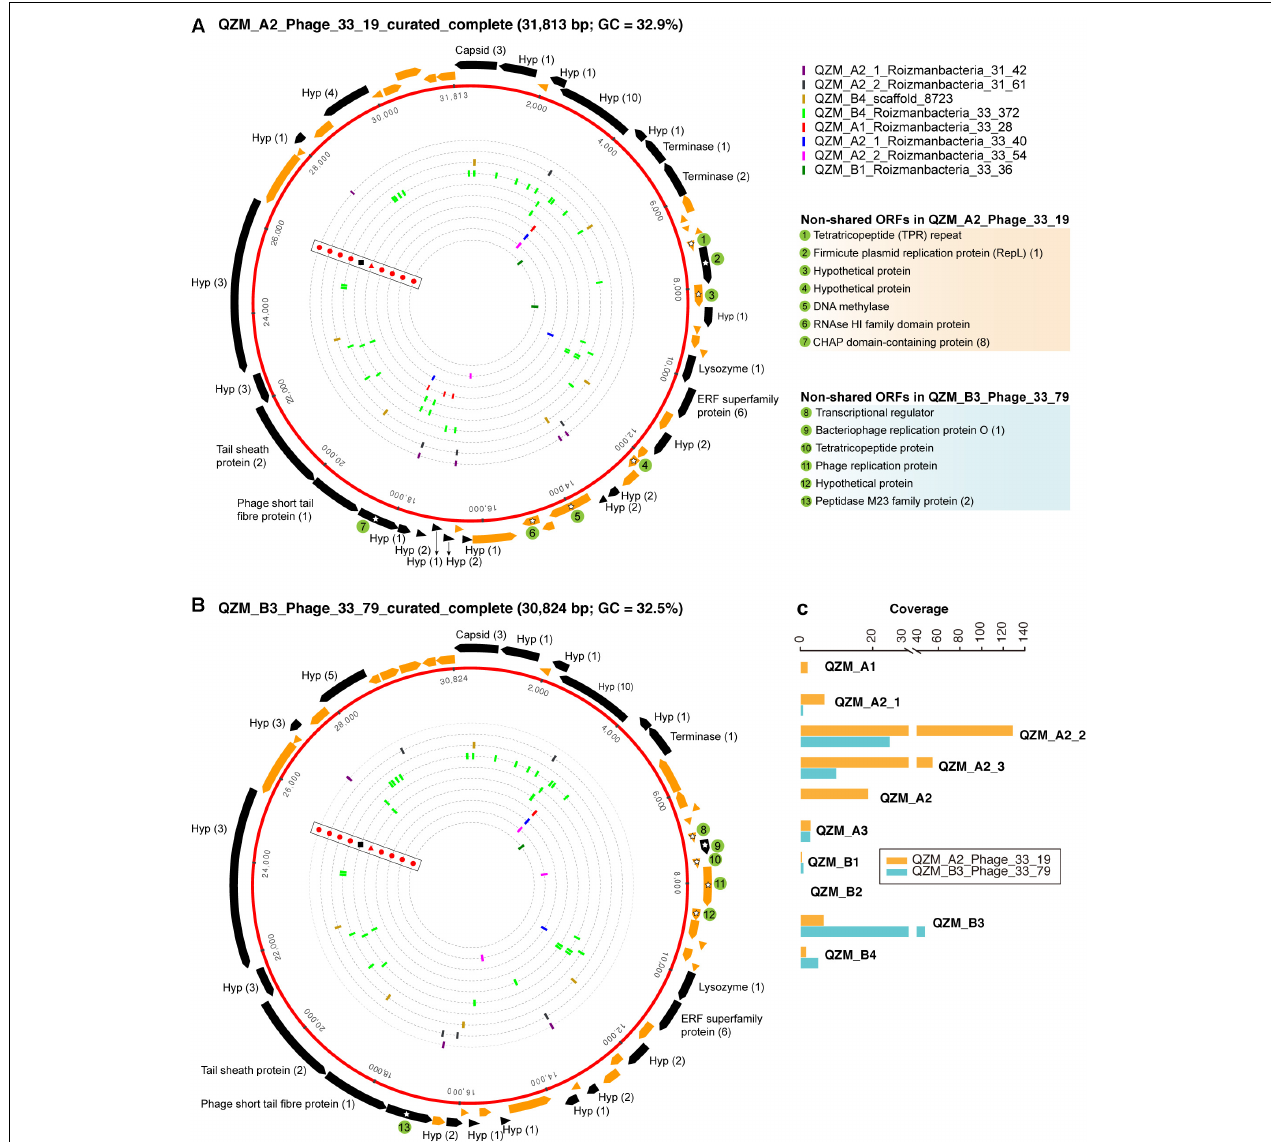
FIGURE 4 | Complete genomes of Roizmanbacteria-infecting phage. The red rings represent (A) QZM_A2_Phage_33_19 and (B) QZM_B3_Phage_33_79 phage genomes. The ORFs are shown outside the genomes, those targeted by at least one spacer are in black (genes not targeted are in orange). The total number of spacers that target each gene is listed in parentheses following the protein annotation. The spacers targeting the phage genome from a given CRISPR-Cas system are indicated by bars on the dotted inner rings (see Figure 1 for CRISPR-Cas system type). Bars are colored by genome of origin (see top right). The non-shared proteins between these two phage genomes are indicated by green circles and numbered, their annotations are shown at the right. Hyp, hypothetical protein. (C) The coverage information of these two phage genomes in QZM-related